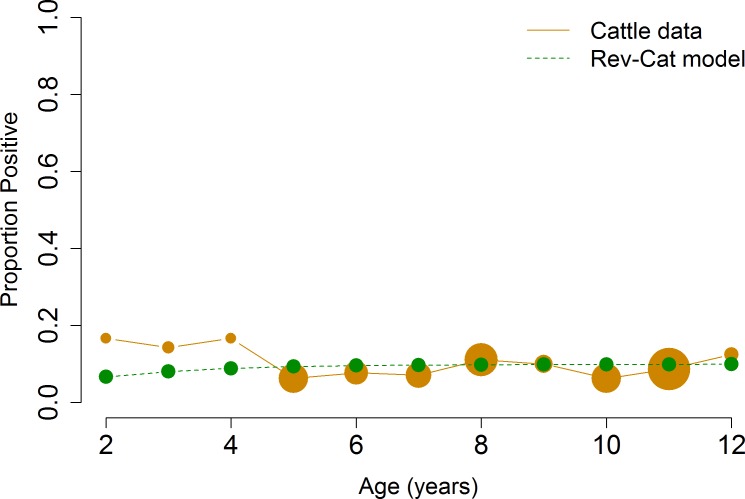
Model selection for cattle.Reverse catalytic model was the best-fit model for cattle. Size of points represents the relative number of animals sampled with that age.